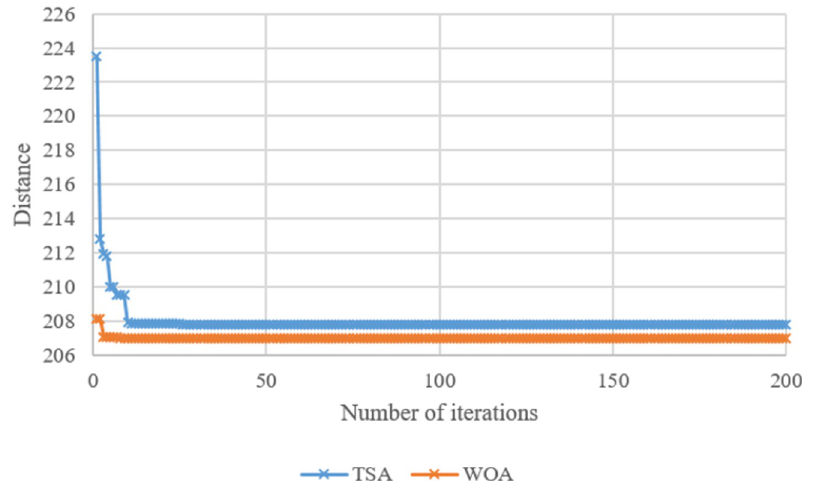
Fig 12. Search history of TSA and WOA for Case- 50 .